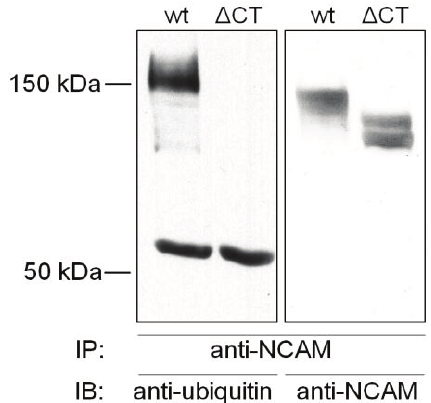
Figure 2. NCAM is ubiquitinated in the cytoplasmic region. B35 cells transfected with NCAM140 wild type (wt) or NCAM140 missing the entire cytoplasmic region ( ∆ CT), respectively, were lysed